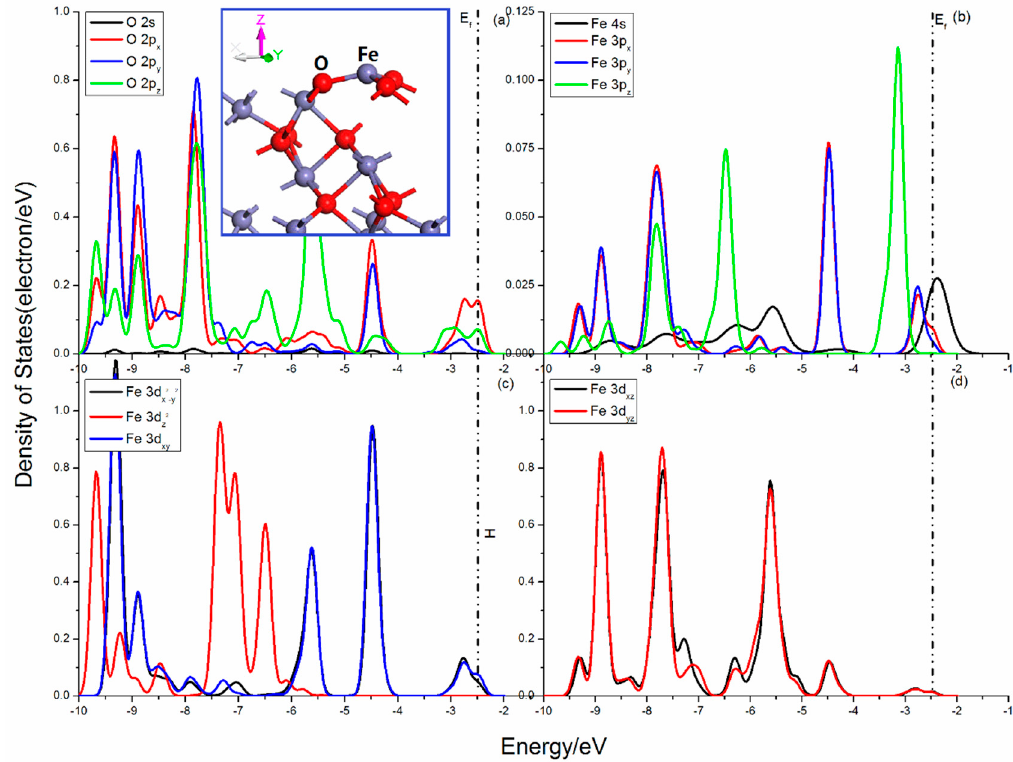
Figure 3. Projected DOSs of O and Fe for hematite (001) surface: ( a ) O 2s, 2p x , 2p y and 2p z states; ( b ) 4s, 3p x , 3p y and 3p z states; ( c ) Fe 3d x2 –y2 , 3d z2 and 3d xy states; ( d ) Fe 3d xz and 3d yz Fe 4s, 3p x , 3p y and 3p z states; ( c ) Fe 3d x2–y2 , 3d z2 and 3d xy states; ( d ) Fe 3d xz and 3d yz states.